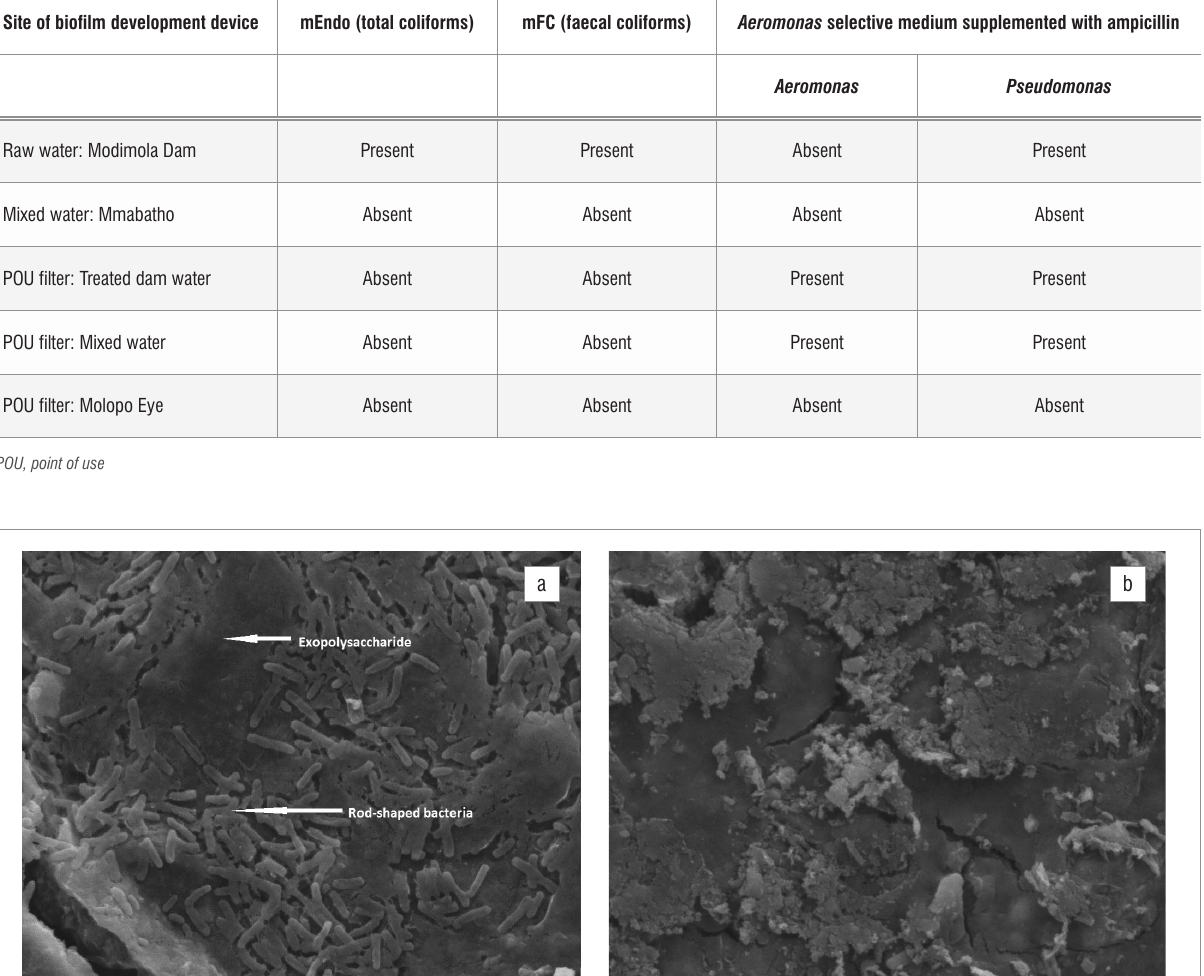
Table 3: Bacteria isolated from biofilms and cultivated on different growth media Site of biofilm development device mEndo (total coliforms) mFC (faecal coliforms) Aeromonas selective medium supplemented with ampicillin